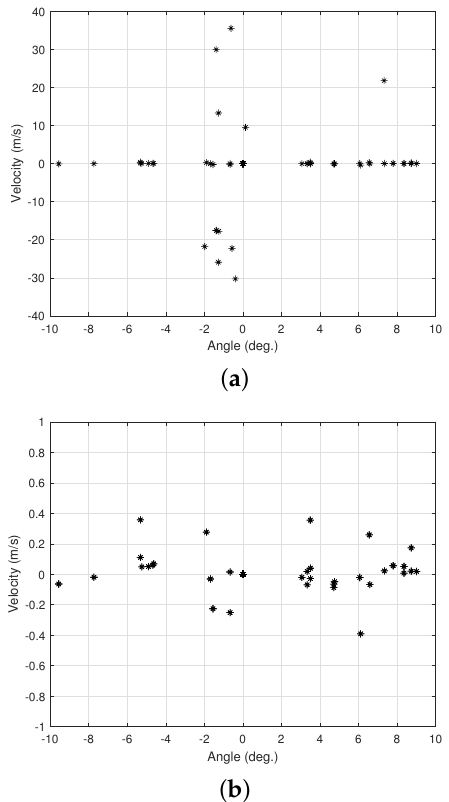
Figure 8. Target detection results in the angle-velocity domain: ( a ) velocity ranges from − 40 m/s to 40 m/s ( b ) velocity ranges from − 1 m/s to 1 m/s (same data as Figure 8a, but reduced velocity